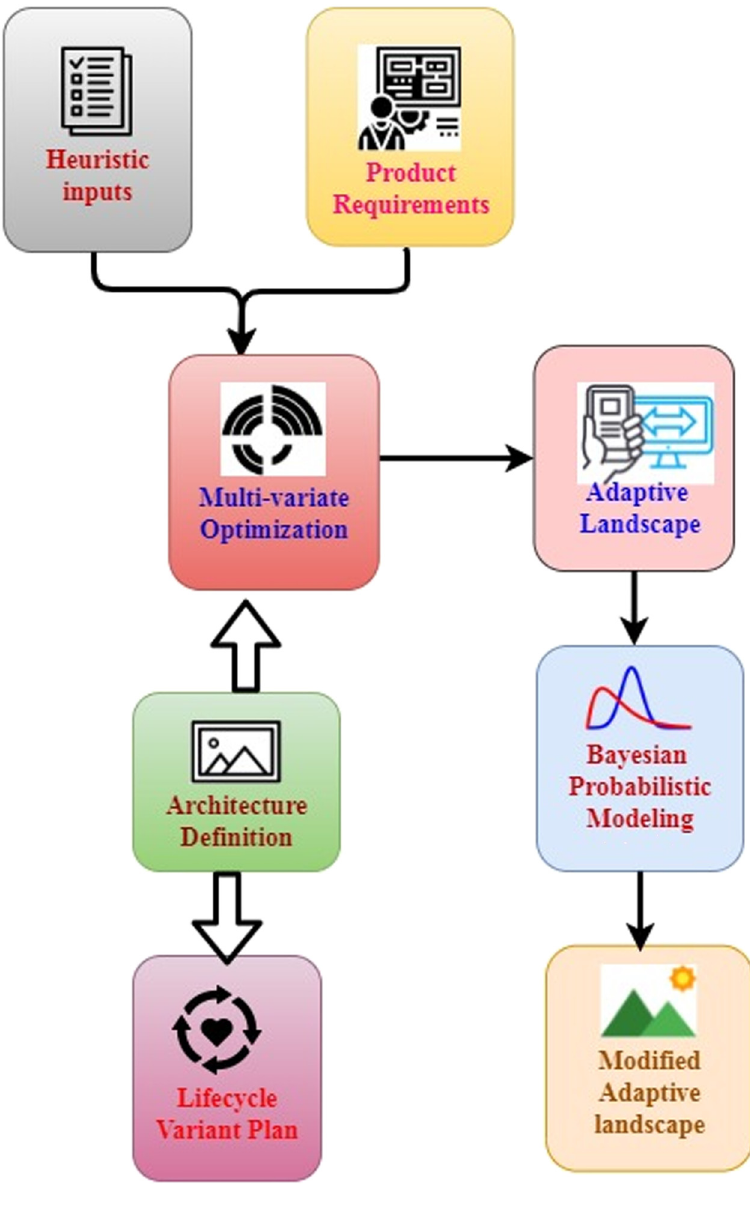
Figure 3: Landscape planning